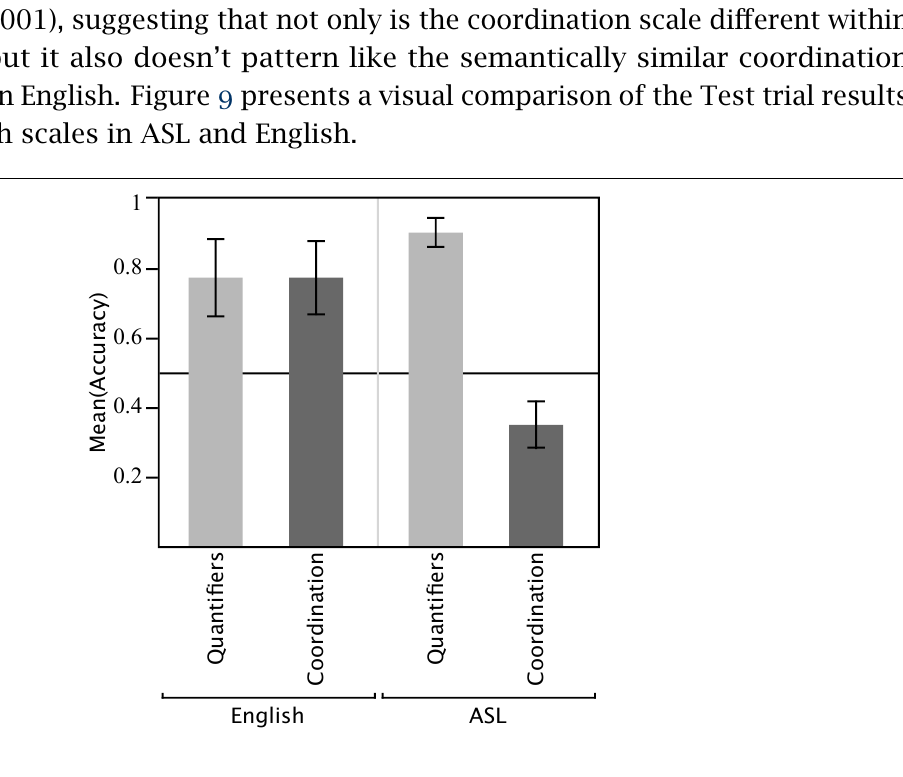
Figure 9 Calculation of implicatures (i.e. rejection rates) on quantifier and coordinator scales in ASL and